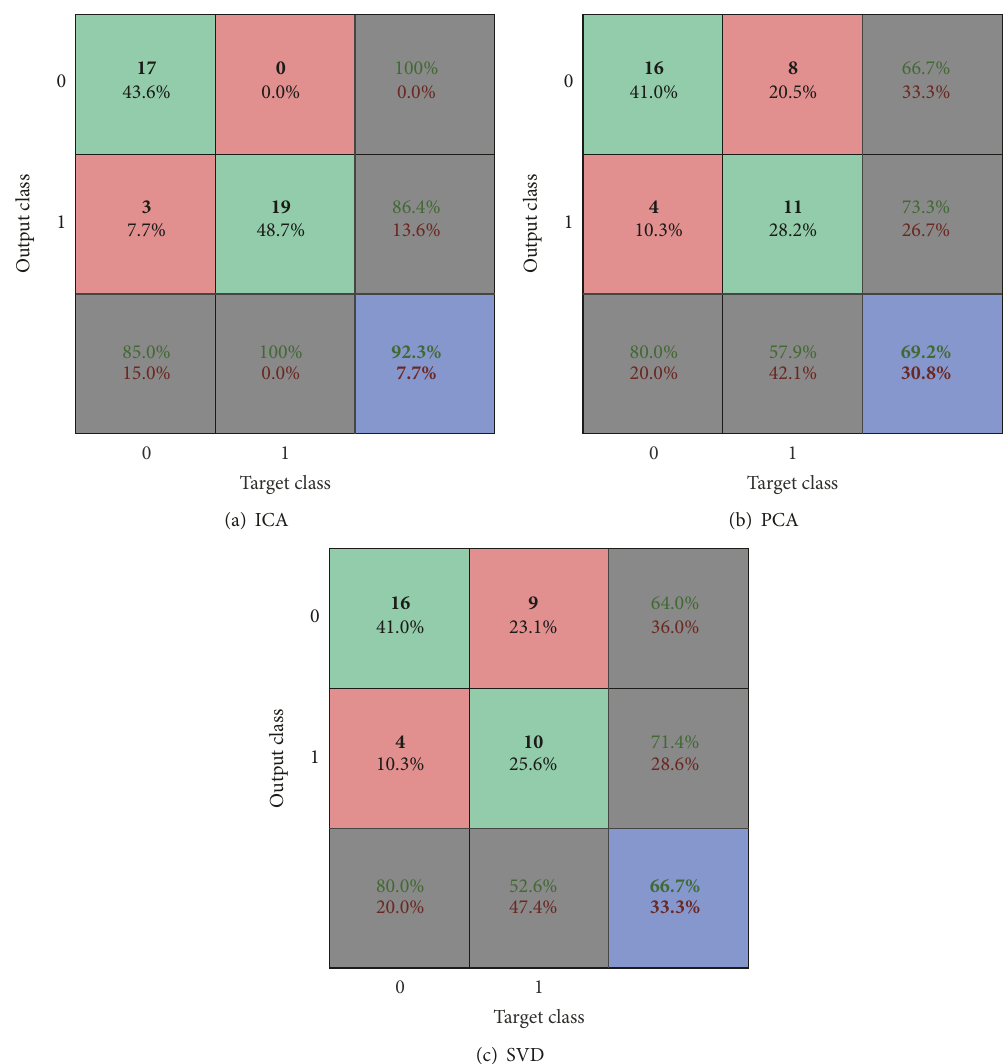
Figure 11: Confusion matrices of classification using the optimized Naive-Bayes for ICA, PCA, and SVD data reduction techniques.